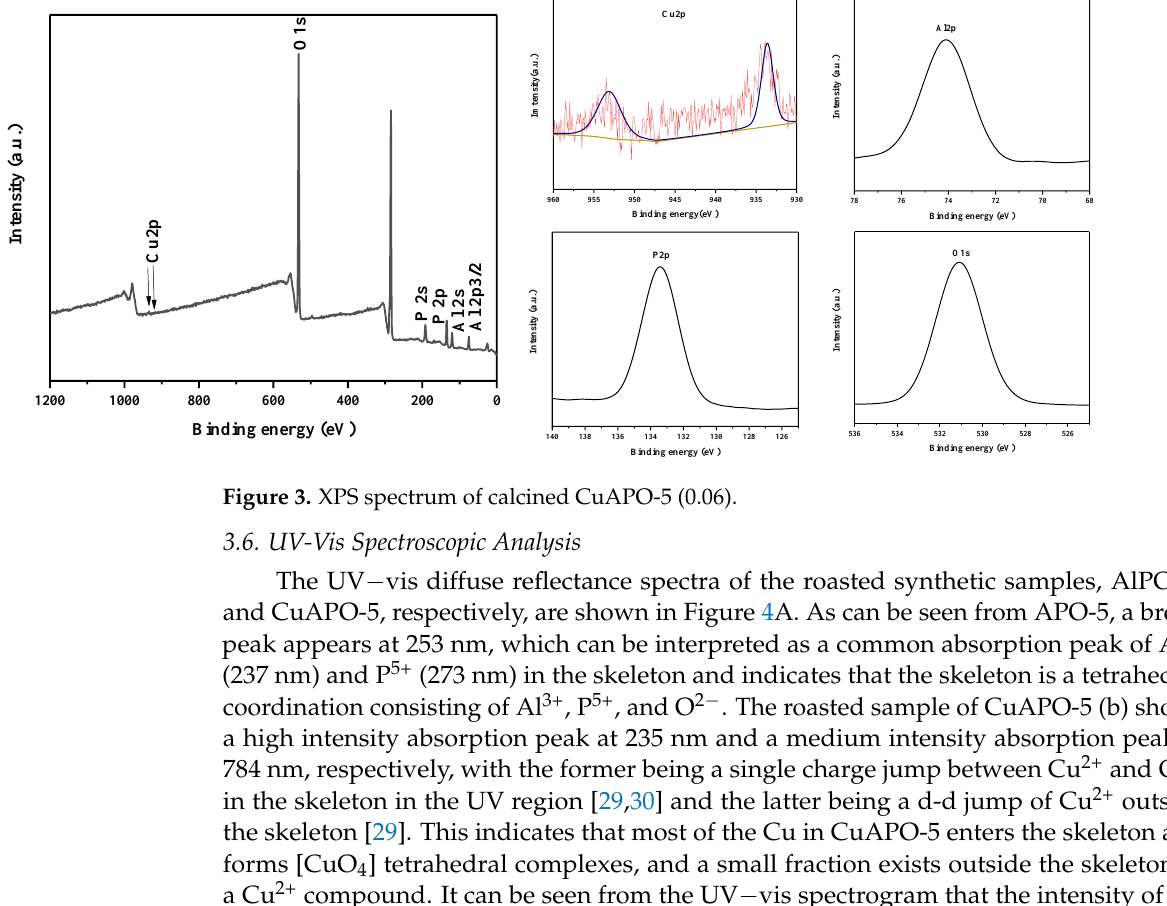
( B ) Figure 2. SEM images of a: AlPO4-5, b: CuAPO-5 (0.03), c: CuAPO-5 (0.06), d: CuAPO-5 (0.09) ( A ), and Electron mapping of CuAPO-5(0.06) ( B ).